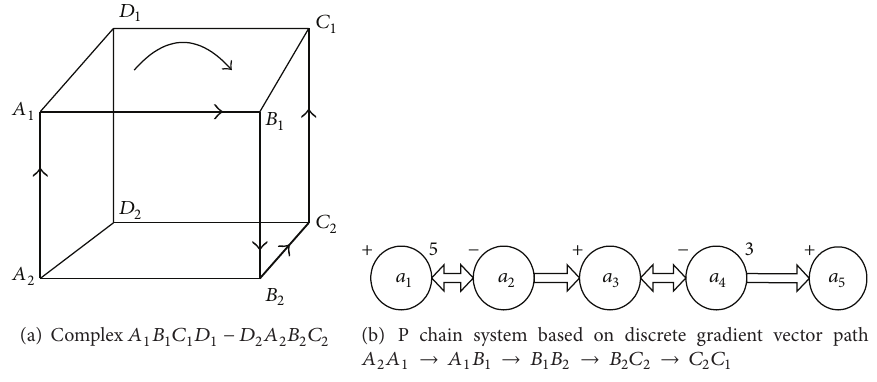
Figure 1: The structure of P chain